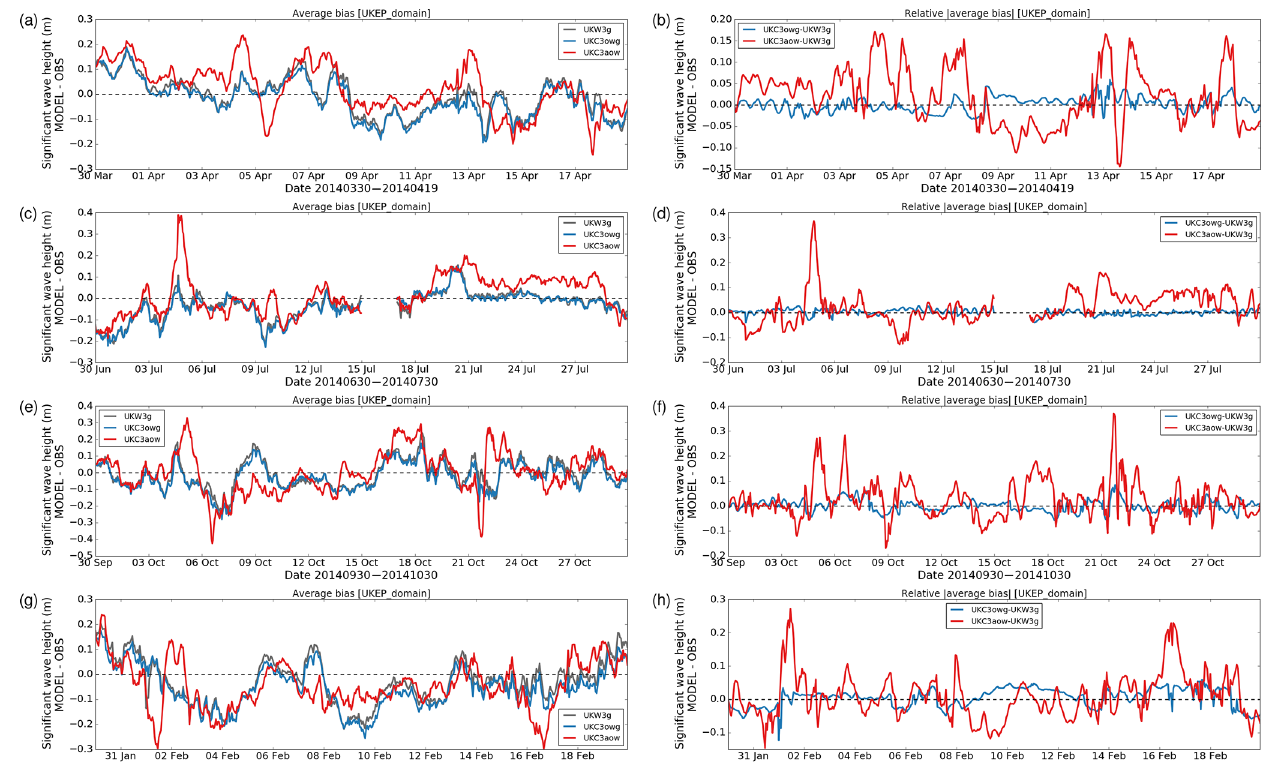
Figure 7. Sensitivity of wave model significant wave height ( H s ) to coupling. (a, c, e, g) Time series of average model–observation (MODEL– OBS) bias across all observing sites for each simulation for July, April, October 2014 and February 2015, respectively. (b, d, f, h) Differences in absolute | MODEL–OBS | bias for each simulation period relative to UKW3g. Note that plots have different scales across the different months evaluated, and observations are compared with a nearest neighbourhood mean of 3 by 3 model grid